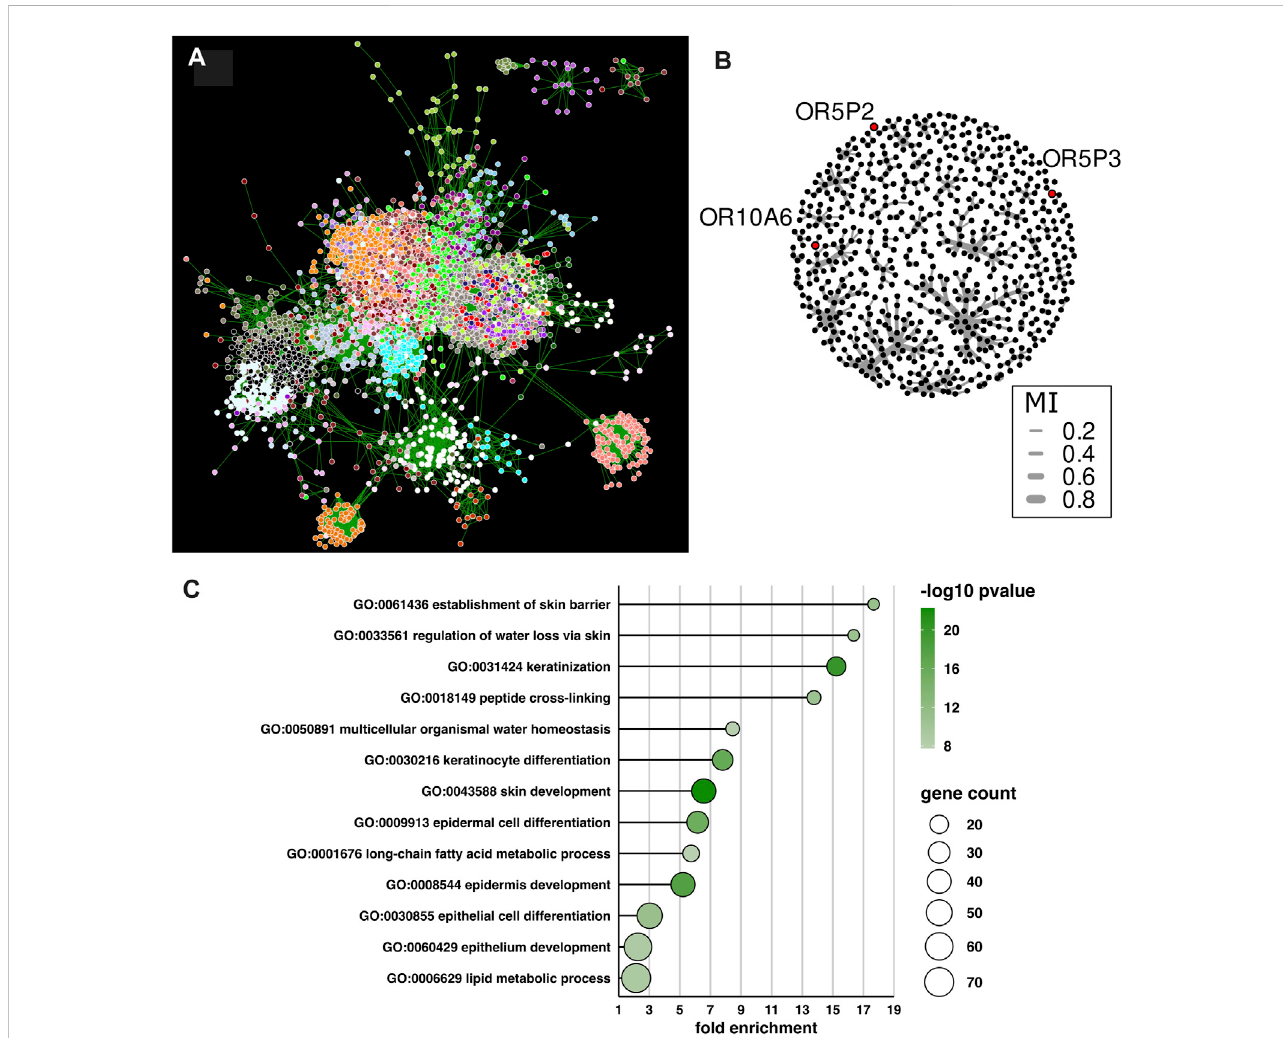
FIGURE 2 WGCNA and c3net analysis of genes expressed in skin tissue. (A) The gene co-expression network using the WGCNA algorithm for genes expressed in skin tissue was visualized using Cytoscape. Each node and edge correspond to gene and TOM similarity, respectively. Only edges for TOM similarity higher than0.025arevisualized.NodeswithoutedgeshigherthanTOMsimilarity0.025wereremoved.ThecolorofeachnodecorrespondstoWGCNAmodules. (B) Sub-network structure of the skin-associated OR-containing module, i.e., the black module. All genes in the black module were visualized using the c3net algorithm, which utilizes maximum mutual information for each gene. Edge width corresponds to mutual information between genes. (C) Gene ontology term enrichment analysis of the black module in WGCNA